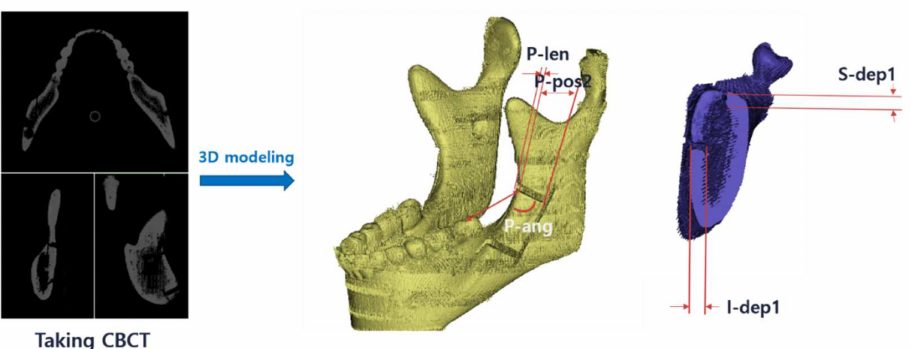
Figure 5. Accuracy evaluation of the mandible ramal bone graft osteotomy using CBCT and 3D modeling with MIMICS software. P-pos: posterior position error, P-len: posterior length error, P-ang: posterior angle error, I-dep: inferior depth error, CBCT: cone beam computer